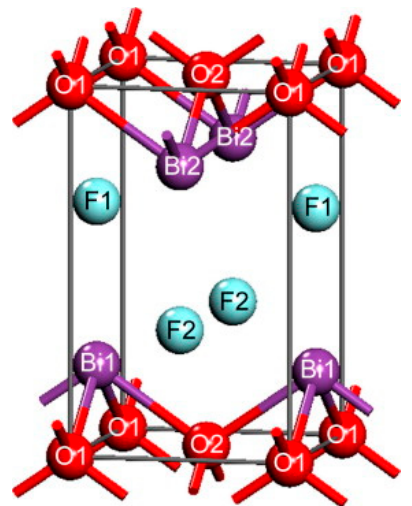
Figure 1. Computer-generated model of BiOX structure. Reused with permission from reference [17].